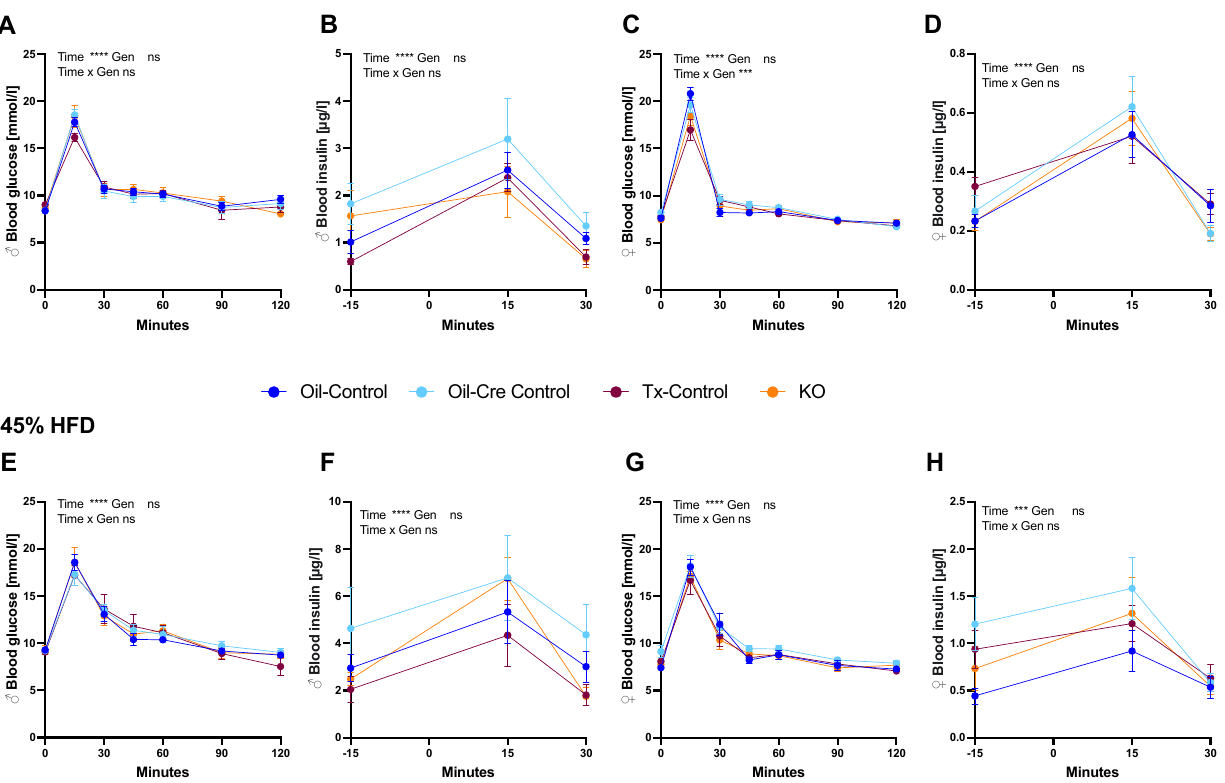
Figure 6. CTR depletion in microglia does not impair glycemic control. Chow or 45% HFD-fed mice received an oral gavage of 2 g/kg glucose after a 2 h fast. A first OGTT was performed for blood glucose measurements ( A , C , E , G ). Two weeks later, a second OGTT was performed for insulin measurements where tongue blood was collected after a brief isoflurane anesthesia ( B , D , F , H ). No significant genotype effects were detected among the groups. Baseline blood glucose and insulin levels were similar across sexes and diet, whereas HFD-fed mice were hyperinsulinemic ( F , H ) and female mice generally had lower levels of insulin ( D ) than males ( B ), as noticed by the scale differences on insulin graphs ( B , D , F , H ). Data are shown as mean ± SEM; n = 6–10 per group; statistical analysis two-way ANOVA with repeated measure for genotype and time; *** p < 0.001, **** p < 0.0001. Last, Iba1 density in the ARC was lower in female KO than in male KO but no difference with their respective controls was measured (Figure